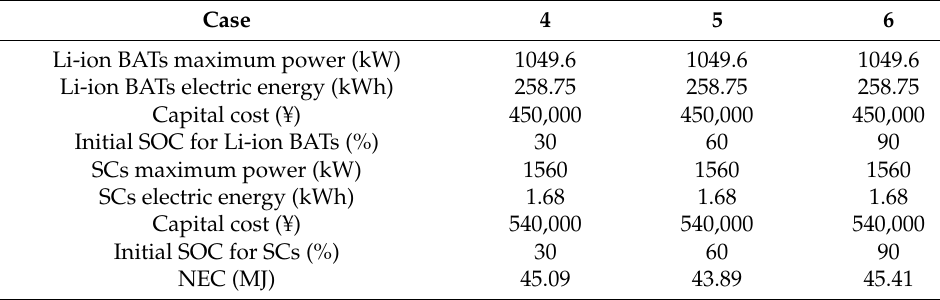
Table 6. The parameters and optimization results for cases